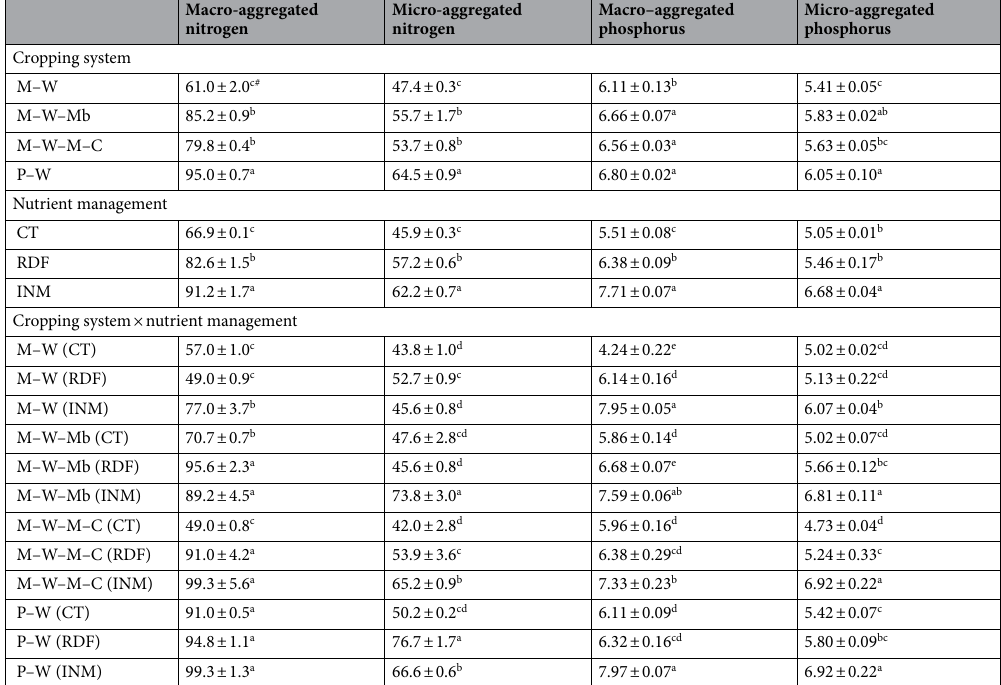
Table 4. Impact of pulses and organic amendments on aggregated nitrogen and phosphorus content (mg kg −1 dry soil). # Lowercase letters (a–d) after values (mean ± standard error) delineates significant difference at p ≤ 0.05 using Tukey’s honest significance test; *denotes interaction is significant; NS =